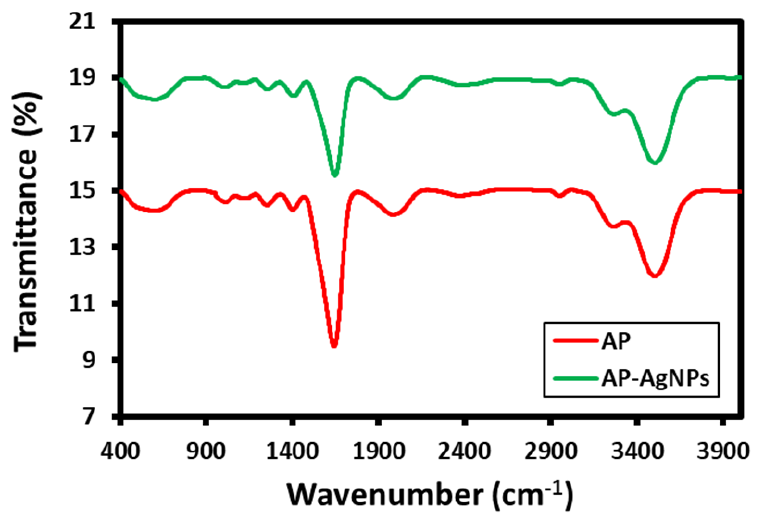
Figure 3. FT-IR analysis of aerial part extract of A. pseudocotula Boiss. plant (AP) and as-synthesized silver nanoparticles (AP-AgNPs).